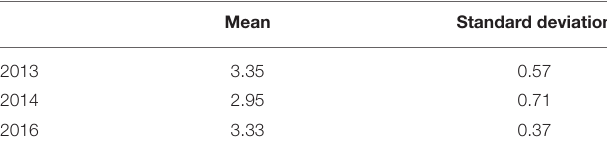
TABLE 1 | Average and standard deviation of the weighted cluster membership defined in Equation (1), calculated over the 45 departments that compose Senegal.